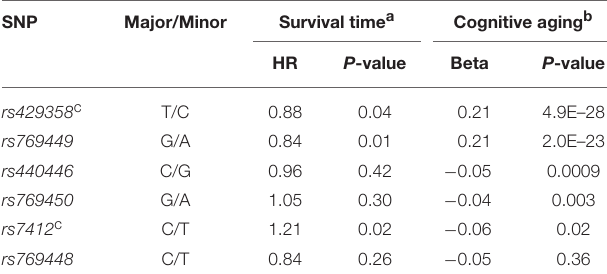
TABLE 2 | APOE SNPs ranked by association with aging